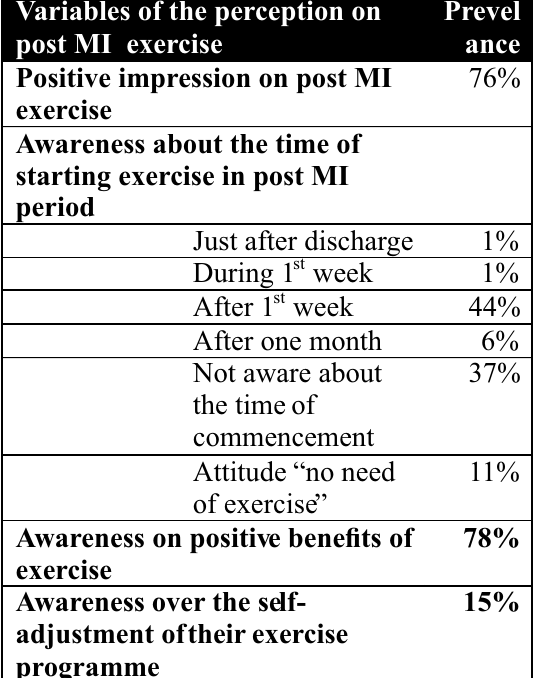
Table 02. Socio-demographic data of the study sample.